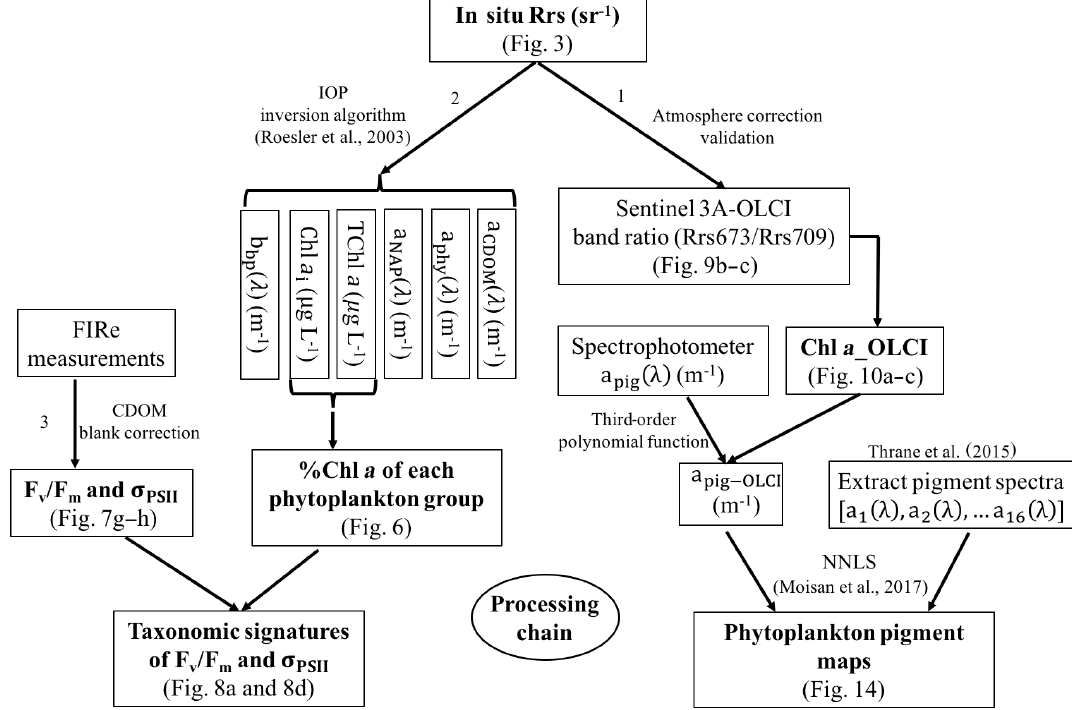
Figure 2. Flowchart showing the three processing steps as follows: (1) retrieving pigments spatial distribution maps from OLCI, (2) distin- guishing phytoplankton groups, and (3) assessing phytoplankton physiological parameters and their linkages to taxonomic groups.